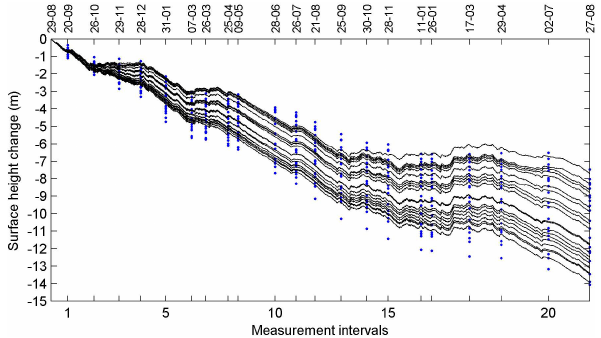
Fig. 4. Results of the leave-one-out-cross-validation: measured (blue dots) and modeled (black solid lines) cumulative surface height change for the study period at each stake. Date as dd.mm is shown on the upper horizontal axis. Individual model parameter combinations for calculating surface height change for each point were derived using the best parameter combination evaluated as run with the smallest mean RMSD considering all other points. For de- tails see Sect. 2.2.3.